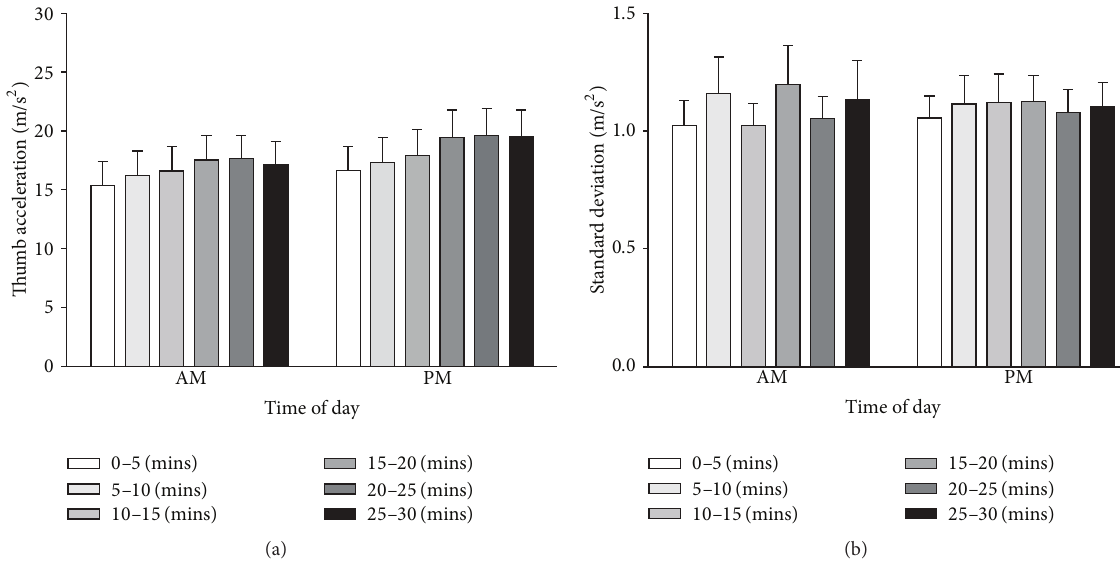
Figure 2: Time of day did not influence neither the maximum left thumb acceleration nor the standard deviation of maximal thumb acceleration during a motor training task. Average APB peak abduction acceleration (a) and standard deviation (b) values (mean ± SEM) were recorded from 22 participants during a motor training task on two separate occasions: morning (AM) and evening (PM). Data are divided into six 5-minute epochs for the motor training task (0–5 mins, 5–10mins, 10–15mins, 15–20 mins, 20–25 mins, and 25–30 mins). Acceleration increased significantly during MT, for both morning and evening sessions. The trial-to-trial variability of acceleration (SD) did not change during MT, and this effect was similar in morning and evening